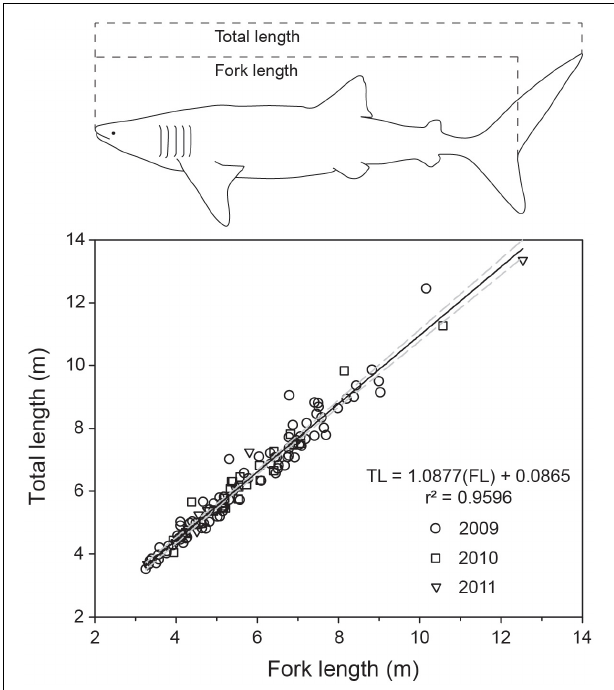
FIGURE 1 | Linear relationship predicting total length from fork length for whale sharks, based on 3 years of sampling and 124 paired shark measurements. Whale shark outline redrawn from Rohner et al.